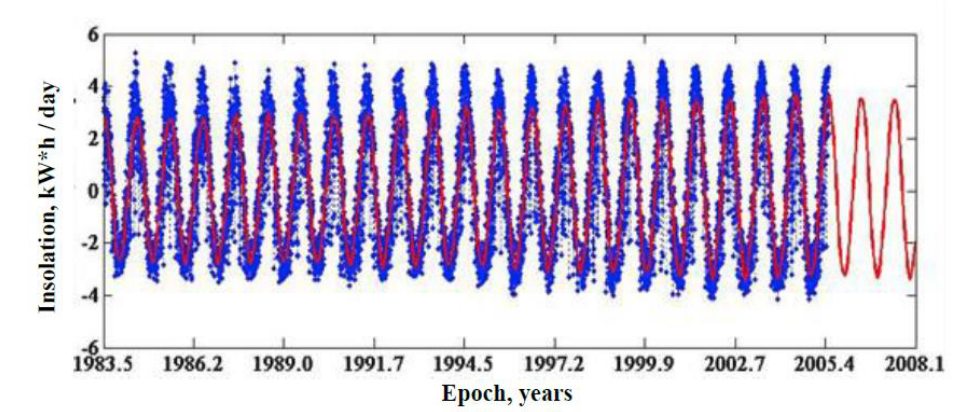
Fig. 2. Data on the insolation of the earth’s surface at Kara -Dag for the period 1983-2005 after the re- moval of irregular “white noise” (marked with asterisks *); approximation curve of the periodic comp o- nent in the data (solid line) calculated using a 6-order sinusoidal model. After 2005.4 -